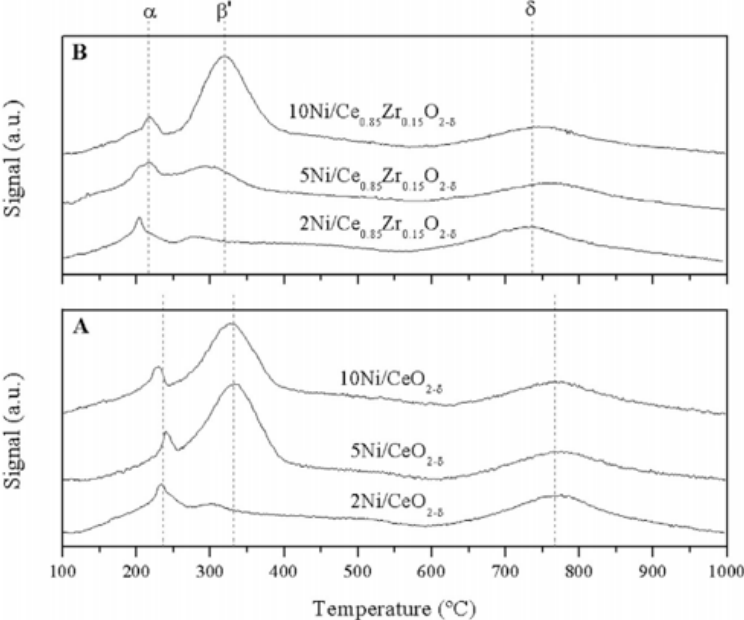
Figure 8. H 2 -TPR profiles for yNi/CeO 2 - δ ( A ) and yNi/Ce 0.85 Zr 0 . 15 O 2- δ ( B ) catalyst showedsimilar trendPeak α which attributed to highly reactive oxygen species lost relevance in contrast to Peak β which attributed to NiO and labile support oxygen concomitant reduction. The bulk oxygen reduction occurred on Peak δ in high temperature region. The ‘ α ’, ‘ β ’ and ‘ δ ’ mark the reduction process. Figure republished with permission from [107]. Copyright Elsevier, 2019.